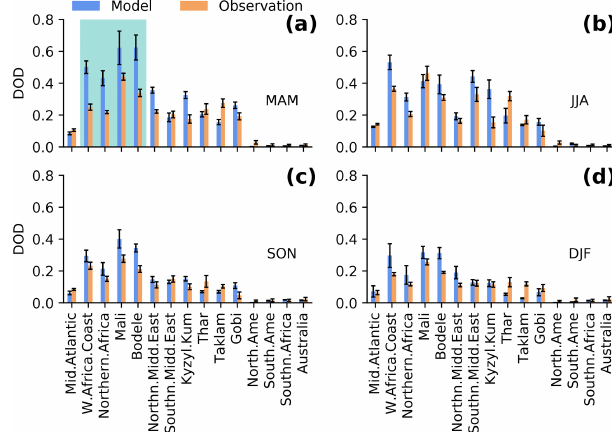
Figure 4. Comparison of seasonally resolved DOD from the base- line simulation (blue) over 15 regions with that (brown) obtained in Ridley et al. (2016), who bias-corrected satellite-based re- trievals from the Moderate Resolution Imaging Spectroradiometer (MODIS) and the Multi-angle Imaging Radiometer (MISR) using AERONET measurements and a model ensemble (see Ridley et al., 2016, for details). The shading area shows an example that the model greatly overestimated DOD compared to observations over some of the subregions. Error bars represent the standard deviation. For definition of the 15 regions see Fig. 1 of Ridley et al.